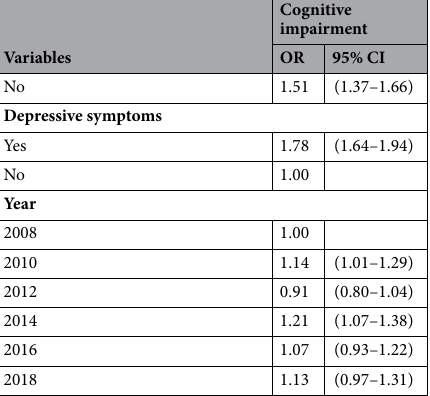
Table 2. Results of generalized estimate equation model on cognitive function according to sensory impairment. ADL activities of daily living; IADL instrumental activities of daily living; BMI body mass index; MMSE mini-mental state examination; CI confidence interval; OR odds ratio. † Hypertension, diabetes, cancer or malignant tumors, chronic lung disease, liver disease, heart disease, cerebrovascular disease, psychiatric disease, arthritis, and rheumatism.